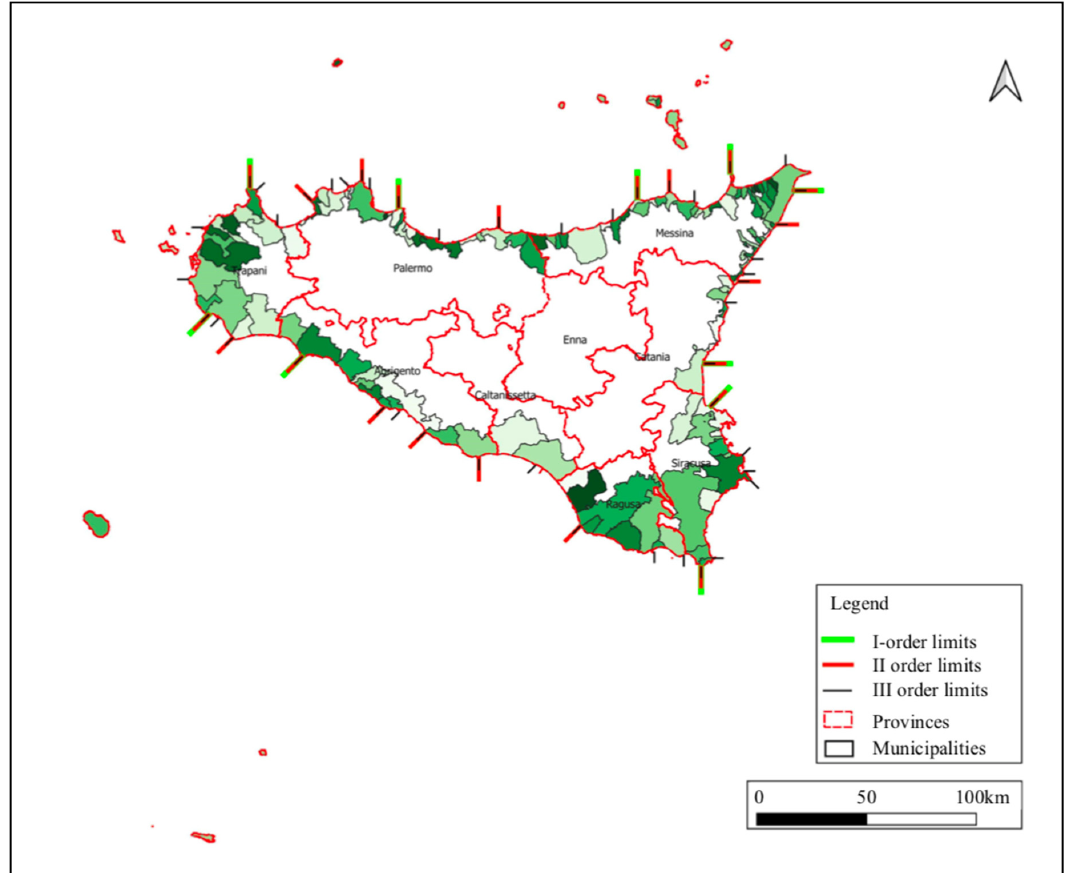
Figure 2. The proposed physiographic unit (PU) partition to create a better interaction among bordering administrations. For each archipelago, there is coincidence between I and II PU order, while each island is a III order PU.